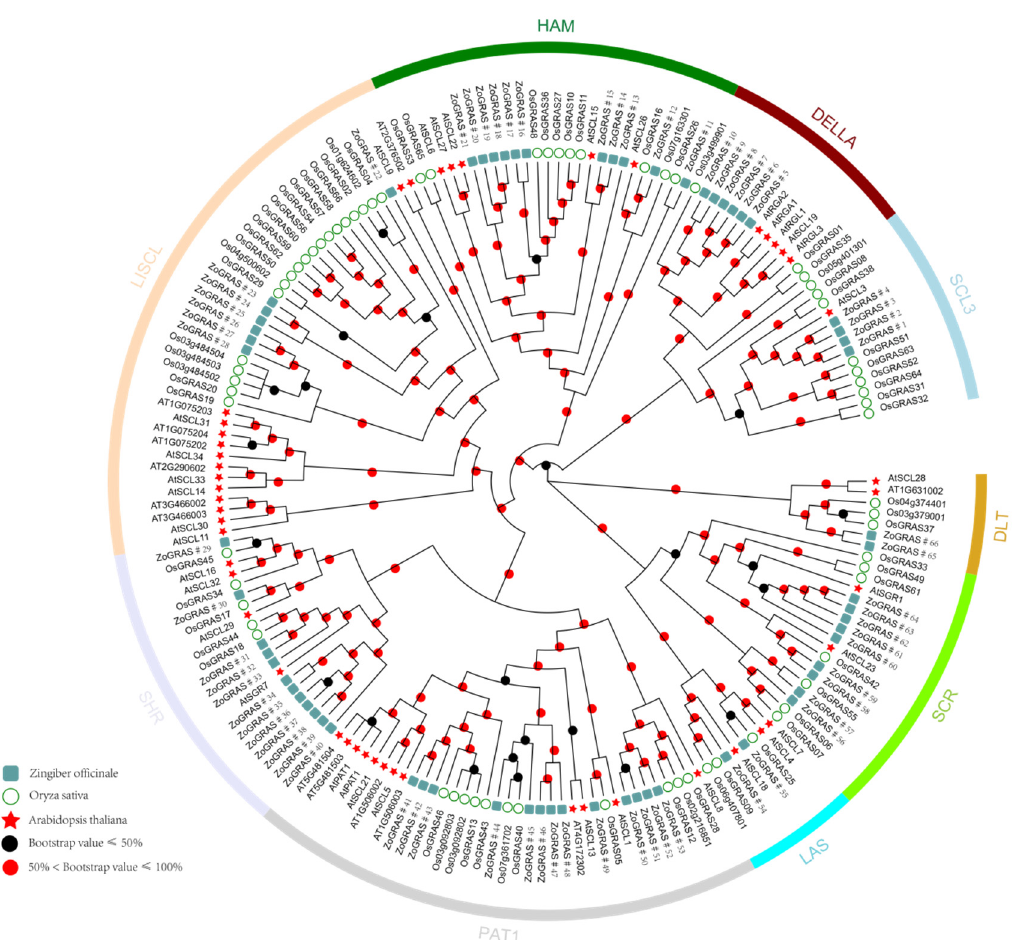
Figure 1. A rootless phylogenetic tree representing 66 GRAS proteins in ginger, rice, and Arabidopsis. The arcs in different color indicate different subfamilies of GRAS. Ginger GRAS proteins with the prefix “Zo” indicate “ Zingiber officinale ”.